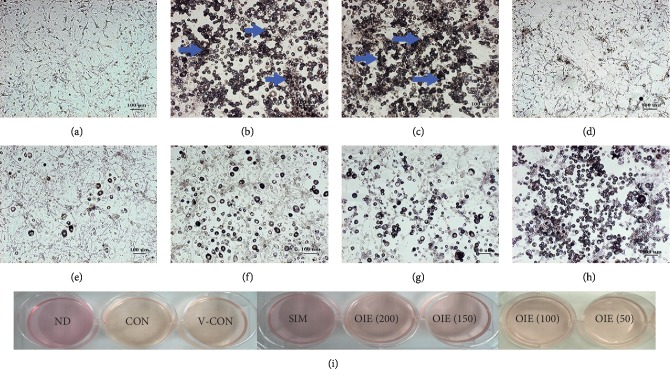
Morphologies of 3T3-L1 preadipocytes after inducing adipogenic inducer and changing the medium color. Arrows indicate lipid droplets. (a) Nondifferentiated cells (ND) or preadipocytes. (b) Untreated adipocytes (CON). (c) Differentiated cells with 0.1% DMSO (V-CON). (d) Differentiated cells with 1.67 μg mL−1 simvastatin (SIM). Differentiated cells with OIE at (e) 200 μg mL−1; (f) 150 μg mL−1; (g) 100 μg mL−1; (h) 50 μg mL−1. (a–h) Scale bar represents 100 μm, magnification at ×40. (i) The color of the media at day 12.